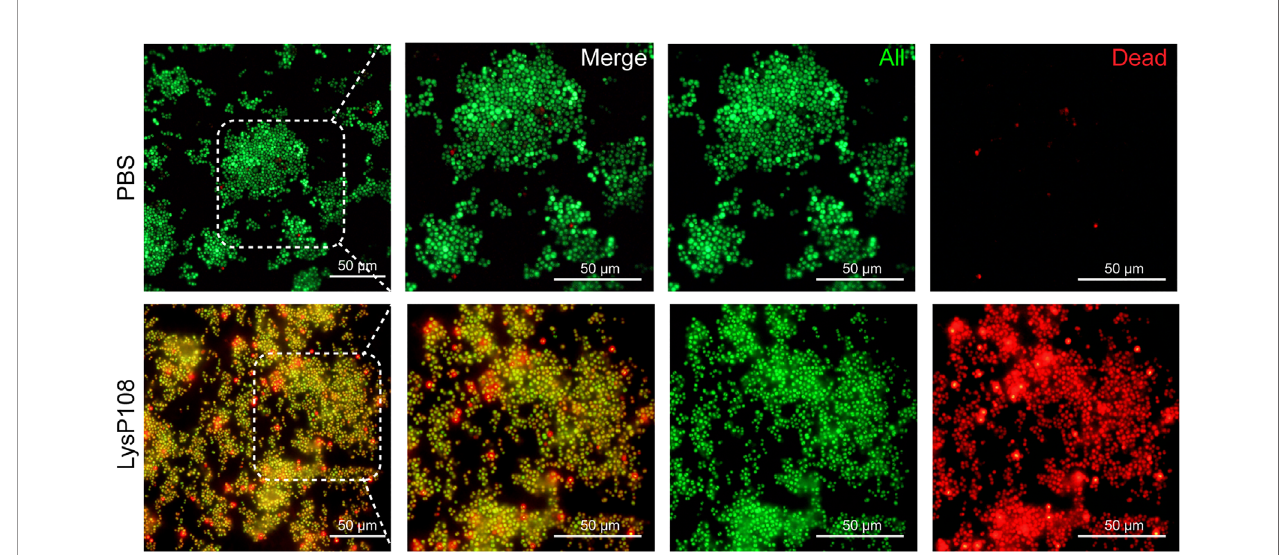
FIGURE 6 | Fluorescent micrographs of live/dead bacteria staining. Green, all bacteria; red, dead bacteria.